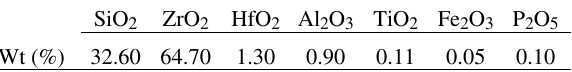
Table 1. Chemical composition of ZrSiO 4 .